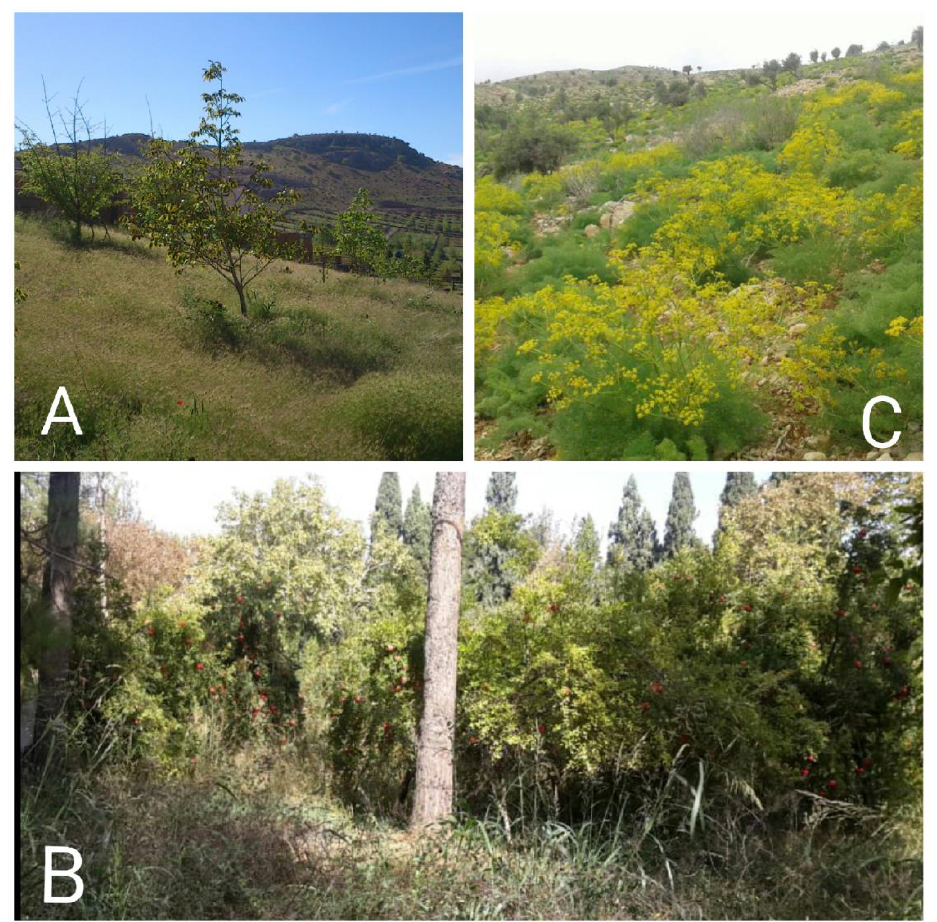
Figs. 2. Habitats of collected flies: A: Dalin, B: Shiraz, Jannat garden, C: Dasht–e